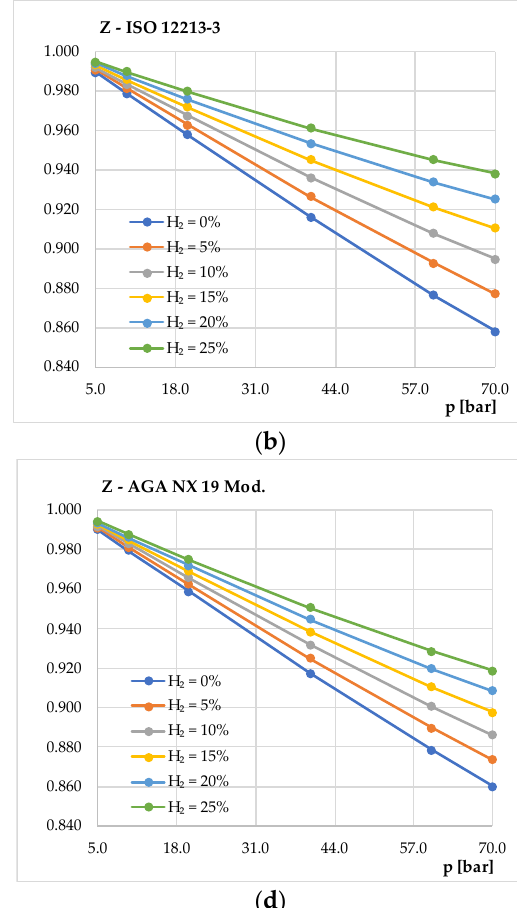
Figure 4. Trend of the compressibility factor in NG and H 2 mixtures: ( a ) ISO 12213-2, ( b ) ISO 12213-3, ( c ) AGA NX 19 and ( d ) AGA NX 19 Mod.